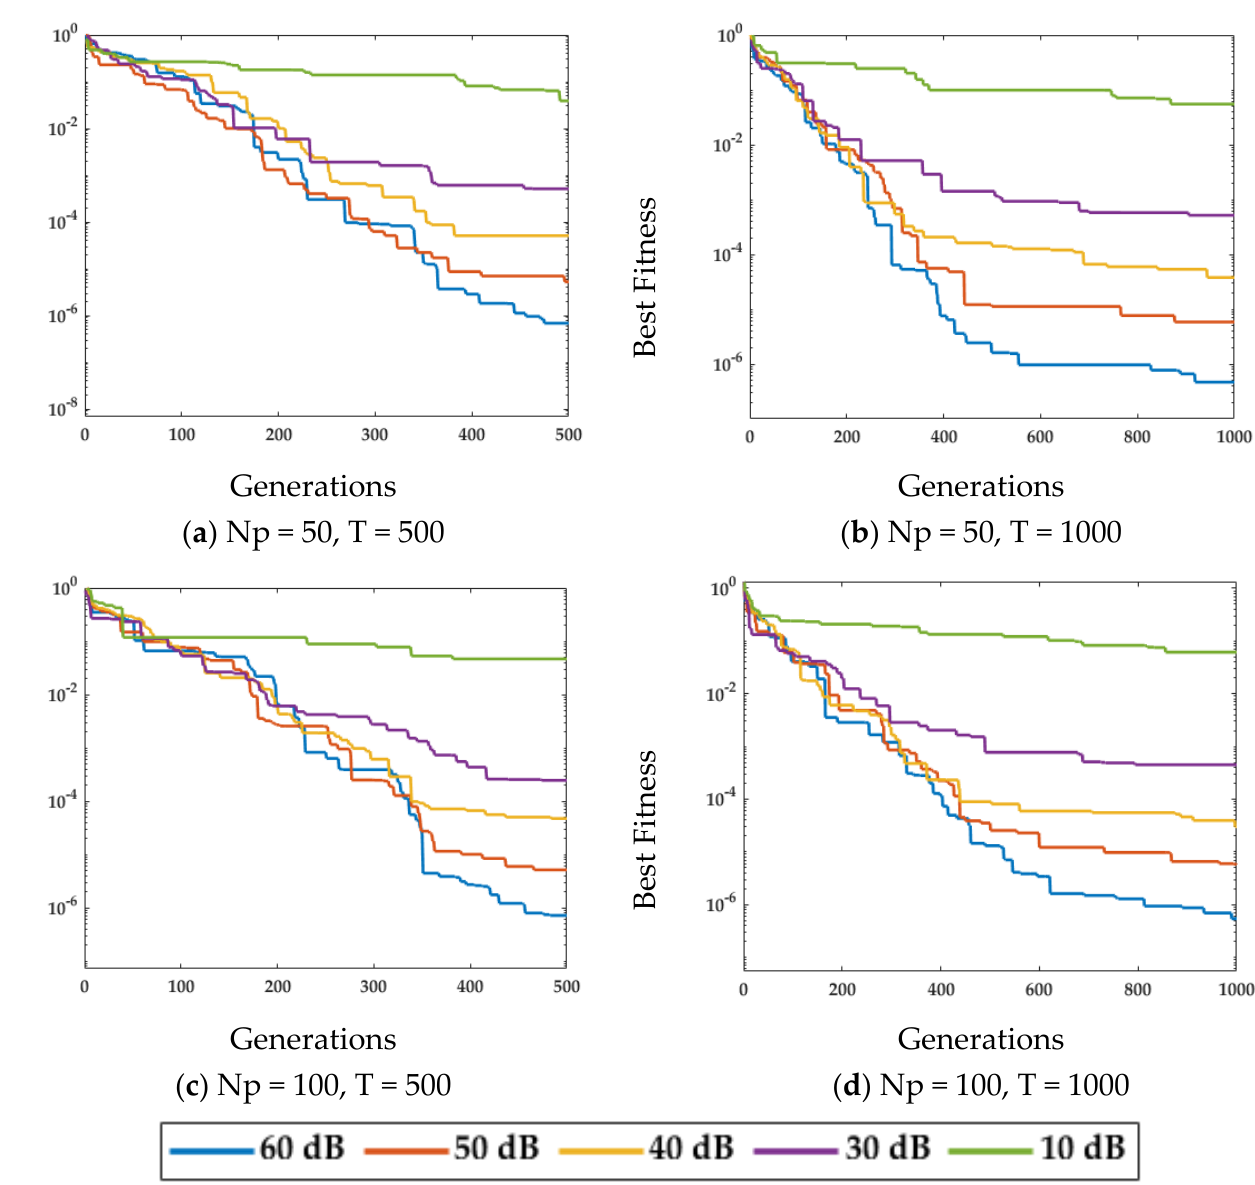
Figure 4. Fitness plots for MPA w.r.t noise levels for case study 1.